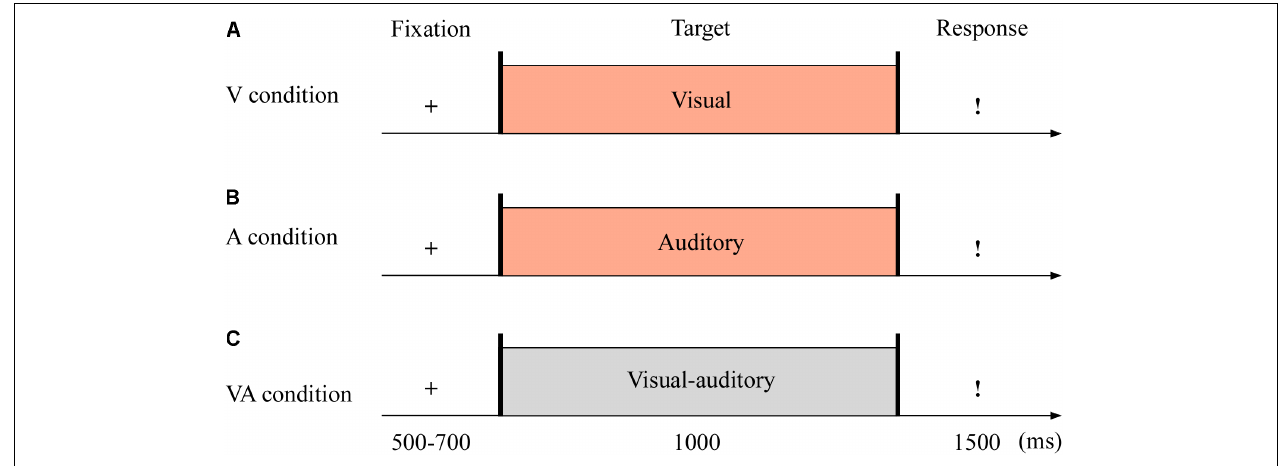
FIGURE 1 | Sampled stimuli and procedure in Experiment 1. The procedure of Experiment 1 showed the sequence of events with a trial for visual sensory (V condition, A ), auditory sensory (A condition, B ), and visual–auditory crossmodal (VA condition, C )